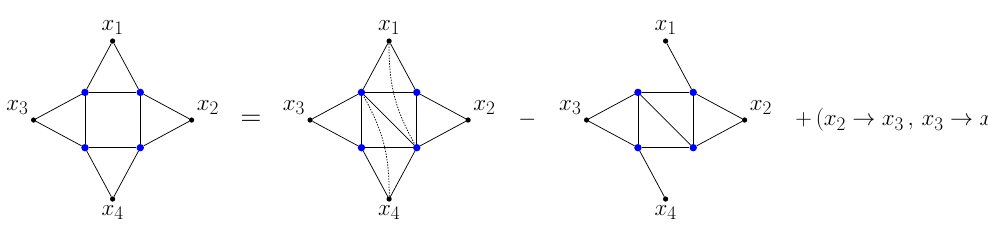
Figure 16 . A new magic identity for four-loop conformal integrals. Solid and dashed lines represent scalar propagators and the inverse